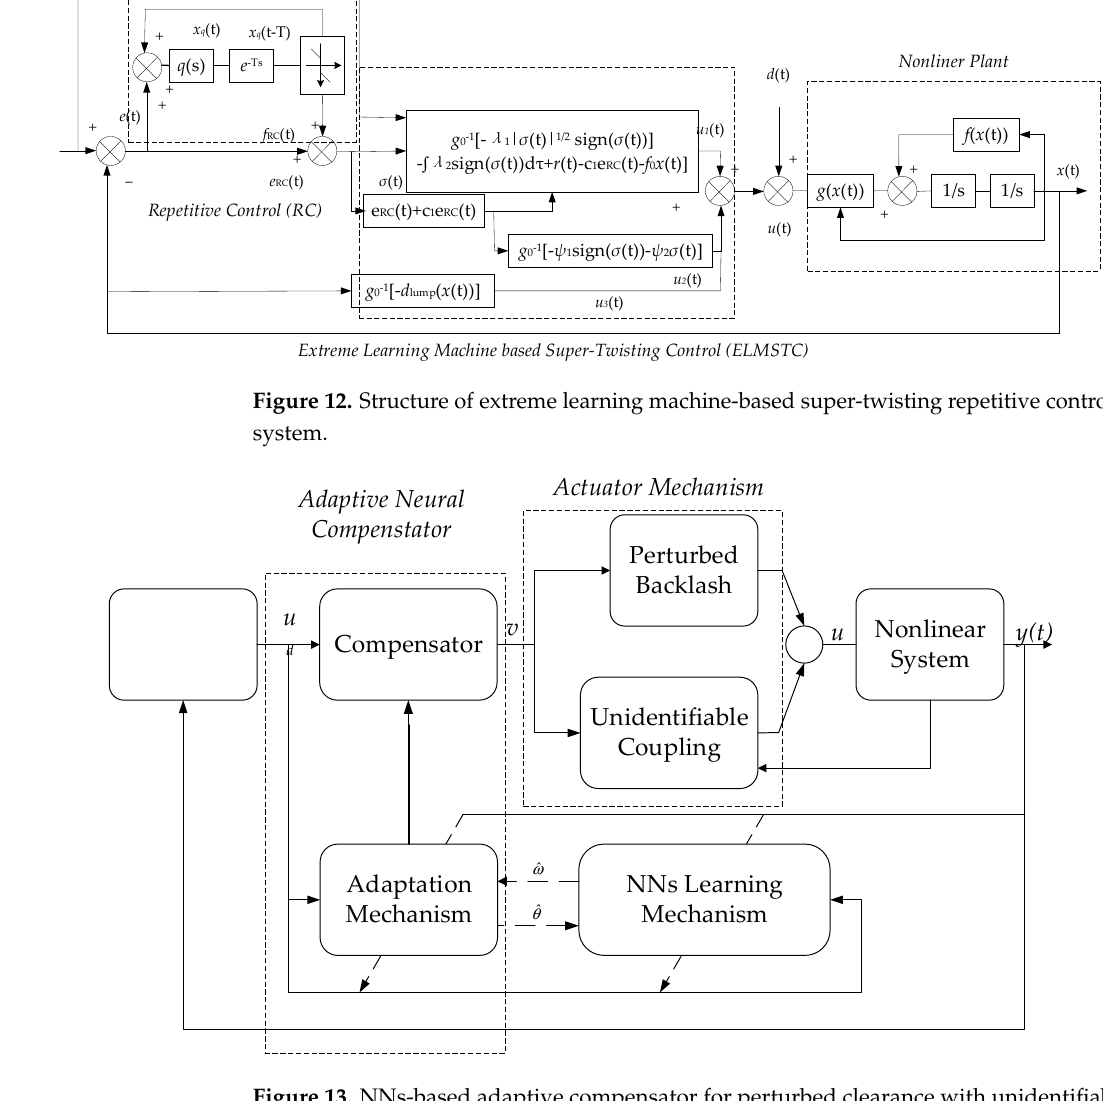
Figure 13. NNs-based adaptive compensator for perturbed clearance with unidentifiable coupling.